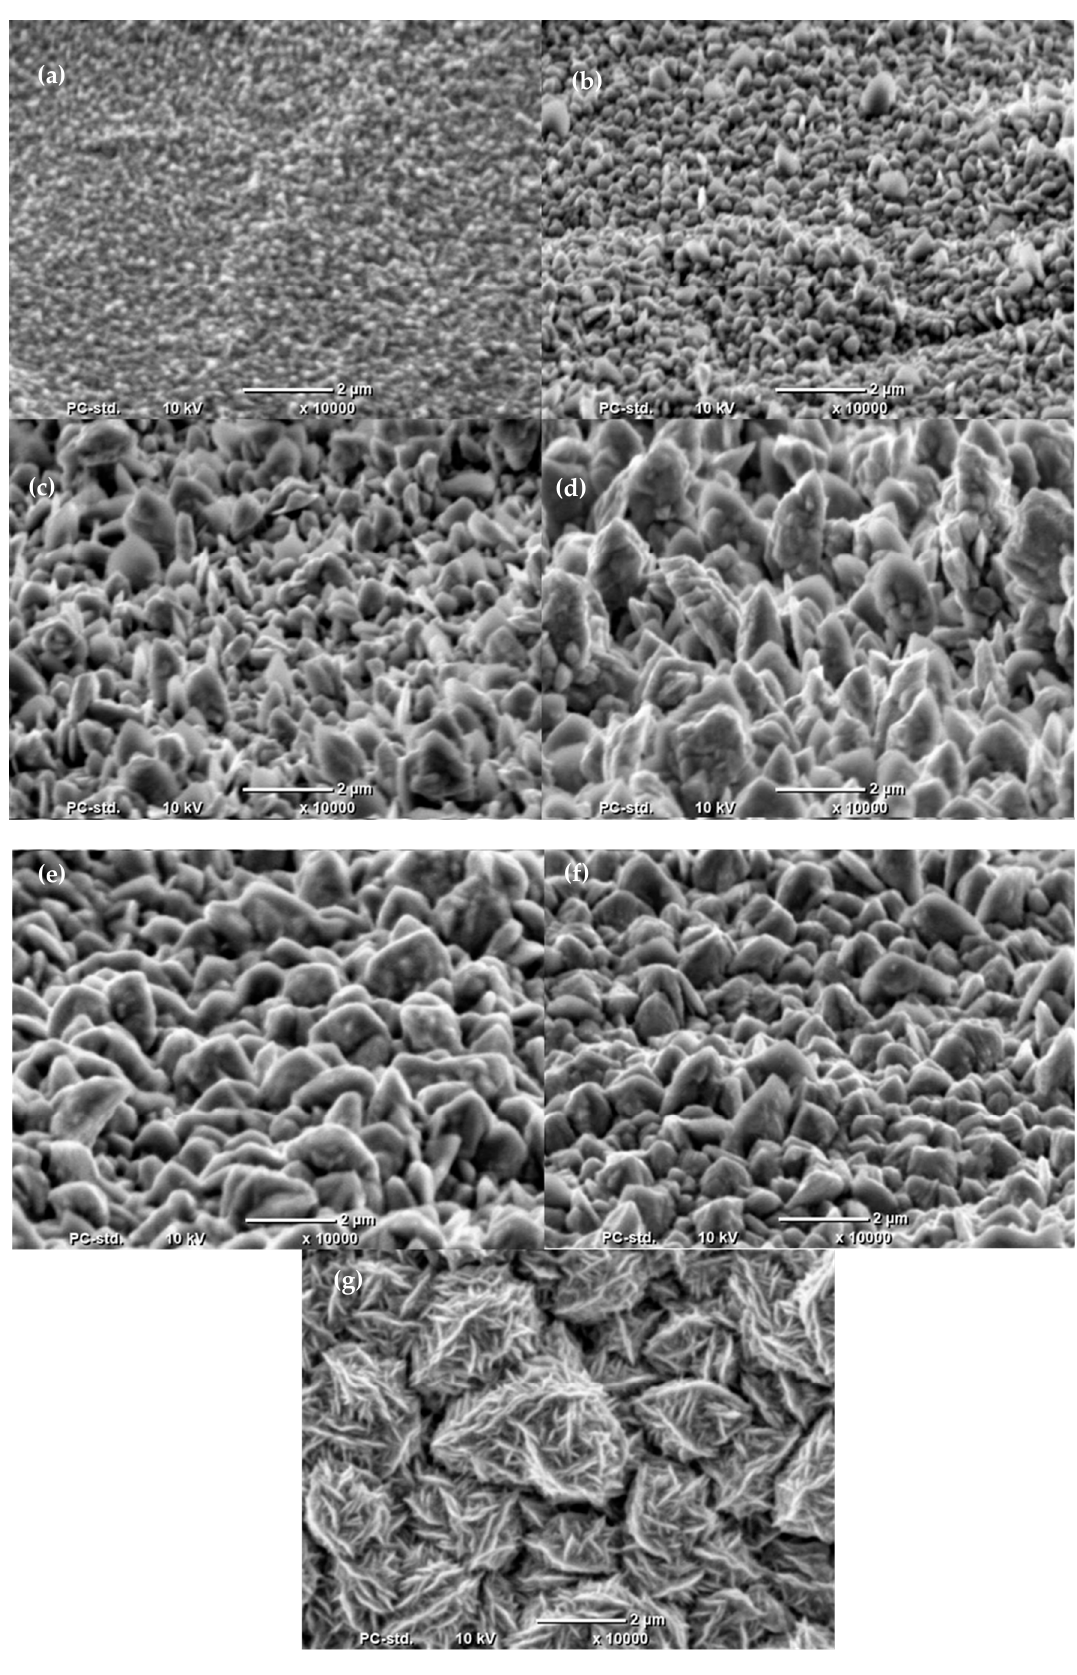
Figure 5. Co cones obtained using one-step method B after ( a ) 10 s, ( b ) 20 s, ( c ) 30 s, ( d ) 40 s, ( e ) 50 s, ( f ) 60 s and ( g ) 120 s of electrodeposition.